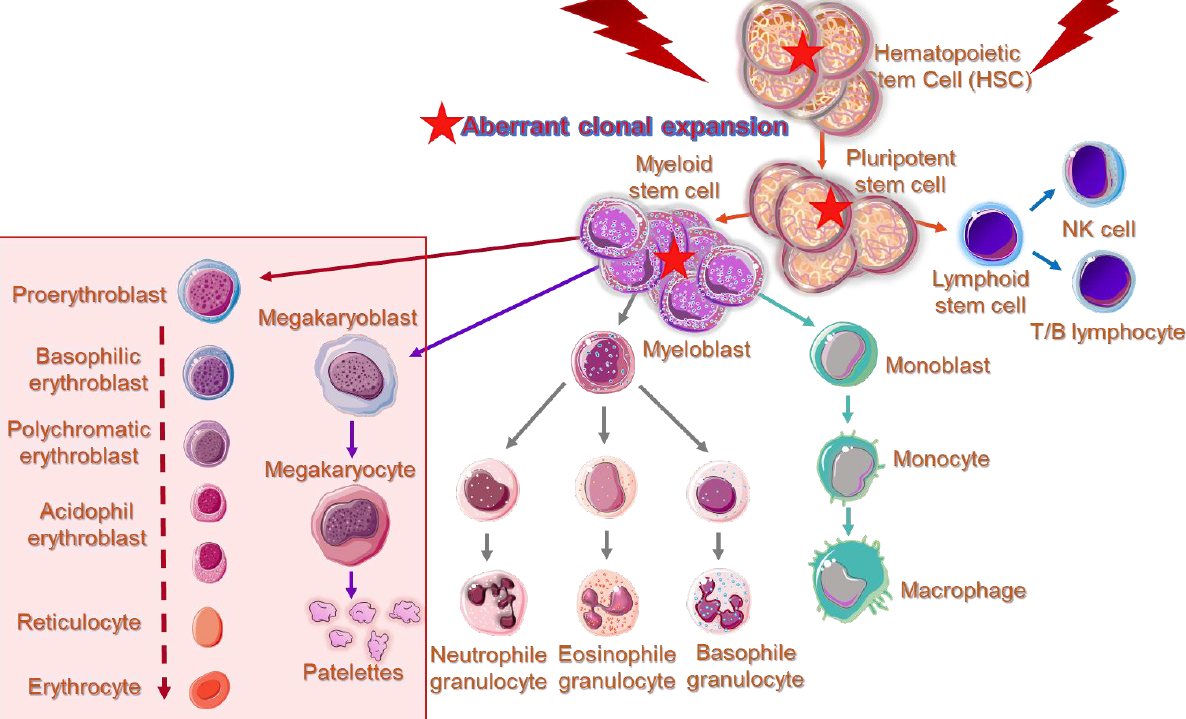
Figure 1. Overview of cells’ aberrations in epigenome of higher-risk MDS patients within the hematopoietic stem cell (HSC) compartment of bone marrow. Impaired gene expression implicated in maturation and differentiation of pluripotent stem cells give rise to myeloid lineage-committed cells showing further phenotypical as well as functional changes. MDS patients of the higher-risk group present significantly expanded granulocytic-monocytic progenitor cells and HSC compartments, while the megakaryocytic – erythroid progenitor cell population is severely reduced. Cellular and molecular changes are in line with the observed cytopenias and emergence of aberrant blast cells in the bone marrow and peripheral blood of higher-risk MDS patients. Aberrant cells characterized by the generation of multiple copies per cell, are indicated by a solid red star. Obstructed pathways of myelopoiesis and erythropoiesis are indicated within a transparent rectangle.